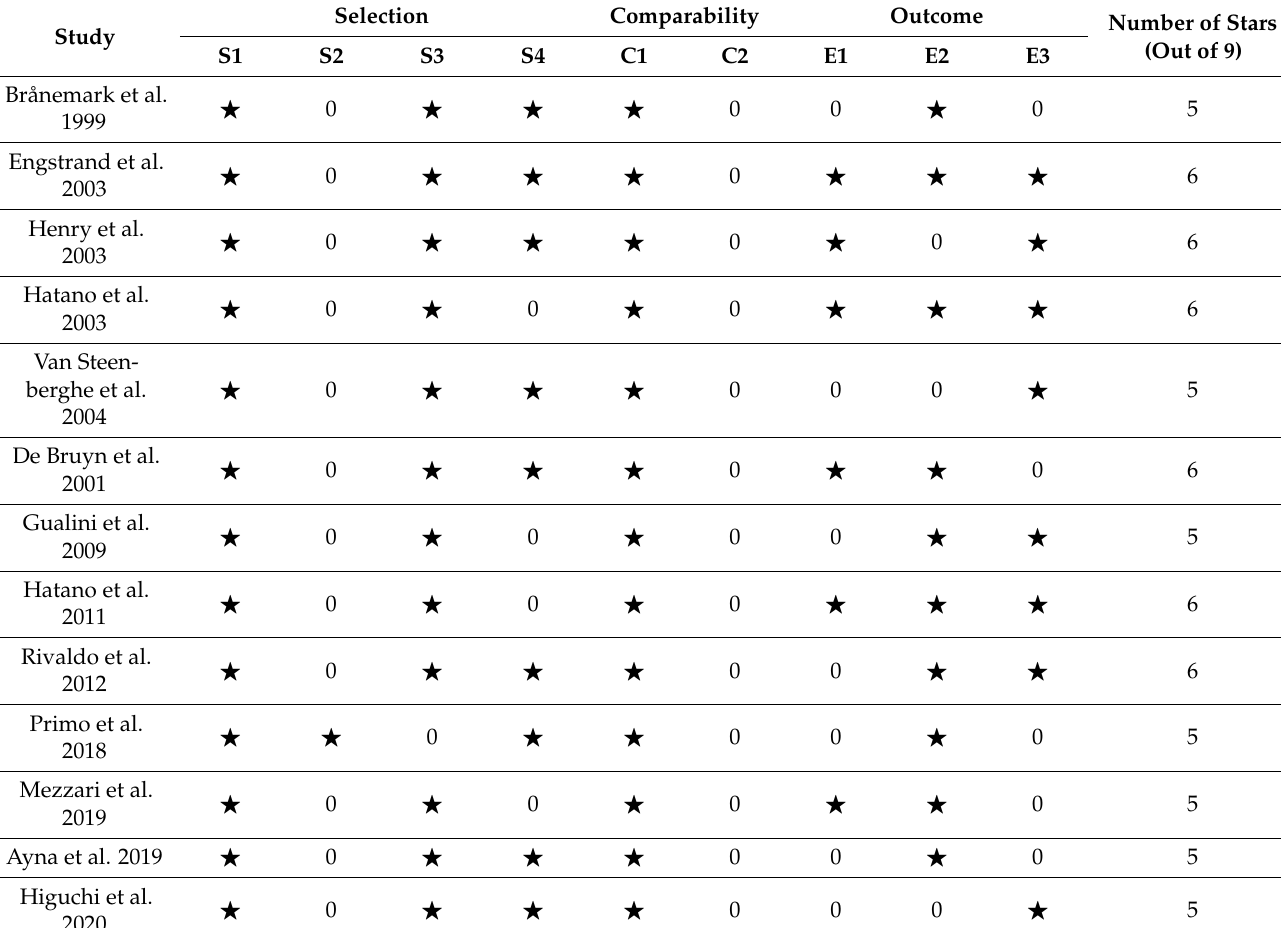
Table 3. Quality assessment of studies reviewed according to the Newcastle-Ottawa